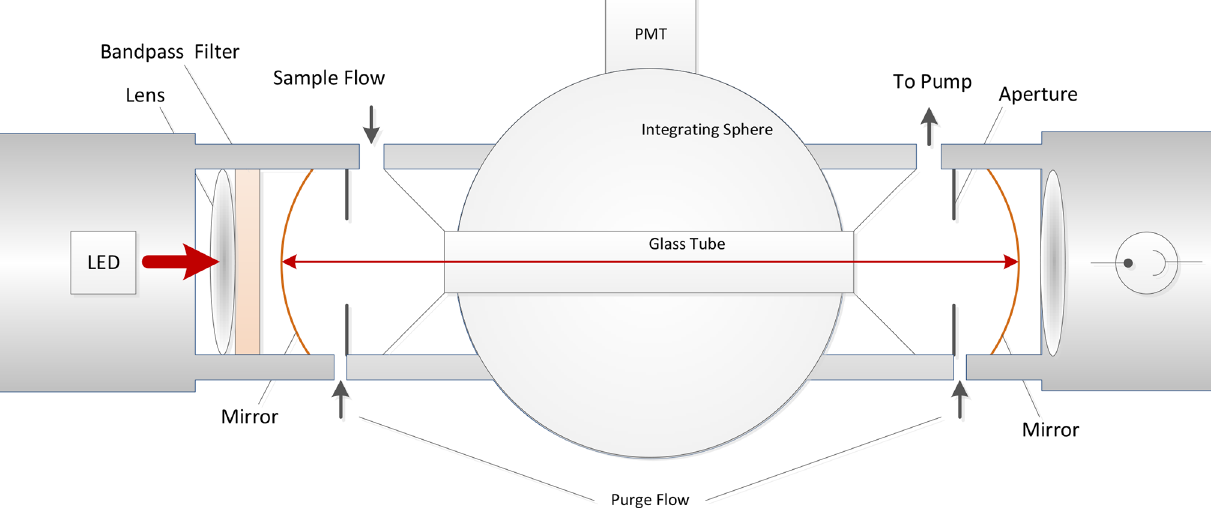
Figure 3. CAPS PM SSA components and setup (not scaled